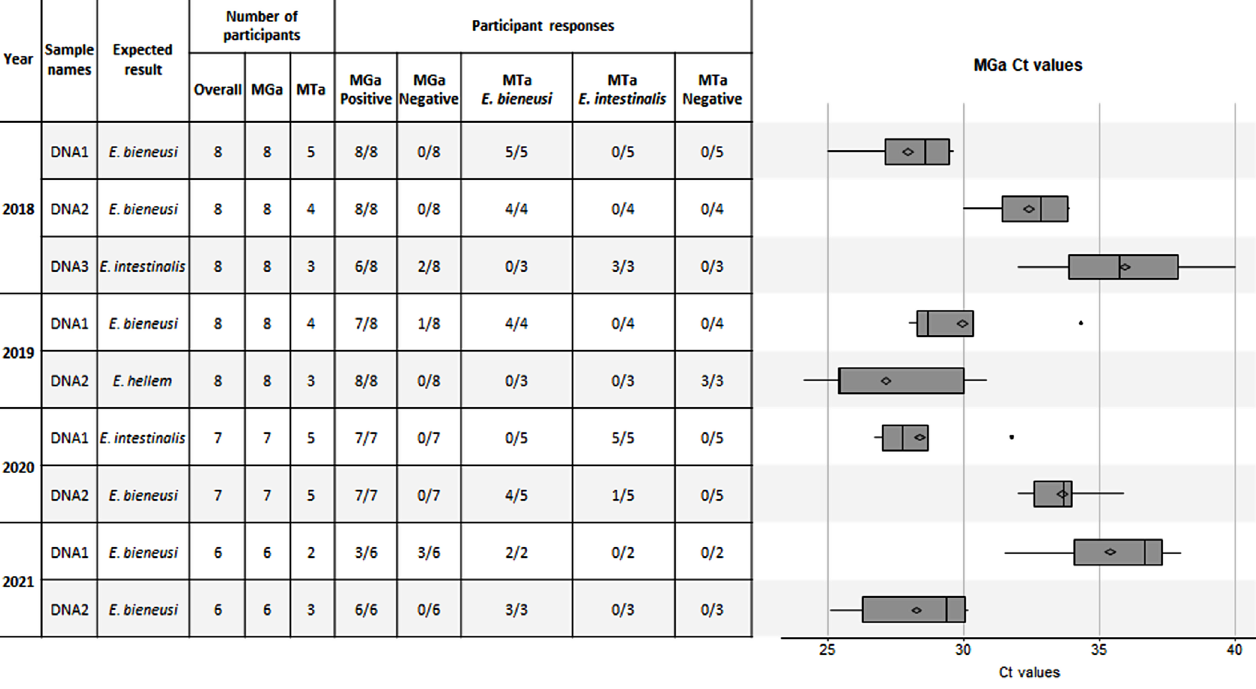
Figure 2. National interlaboratory quality control program: quantitative and qualitative results. Qualitative (left part) and quantitative ( Ct values, right part) results of the Microsporidia generic PCR assay (MGa) and the Microsporidia typing assay (MTa) during the four-year